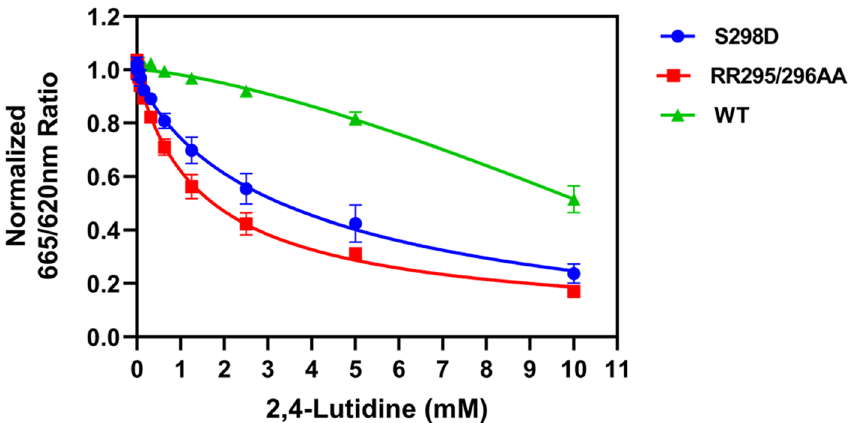
Figure 8. TTD-PHD linker mutants (S298D and RR295/296AA) are more sensitive to 2,4-lutidine inhibition. The TTD-PHD S298D mutant mimics Ser298 phosphorylation while the RR295/296AA mutates at the crucial sites that bind to the Arg binding groove of TTD. Both mutants damaged the interaction between the linker and the Arg-binding pocket. Using TR-FRET assay to characterize the 2,4-lutidine dose-dependent inhibition effect on the TTD-PHD:H3K9me3 peptide interaction clearly showed that the S298D and RR295/296AA mutants were more sensitive to 2,4-lutidine comparing to wild type